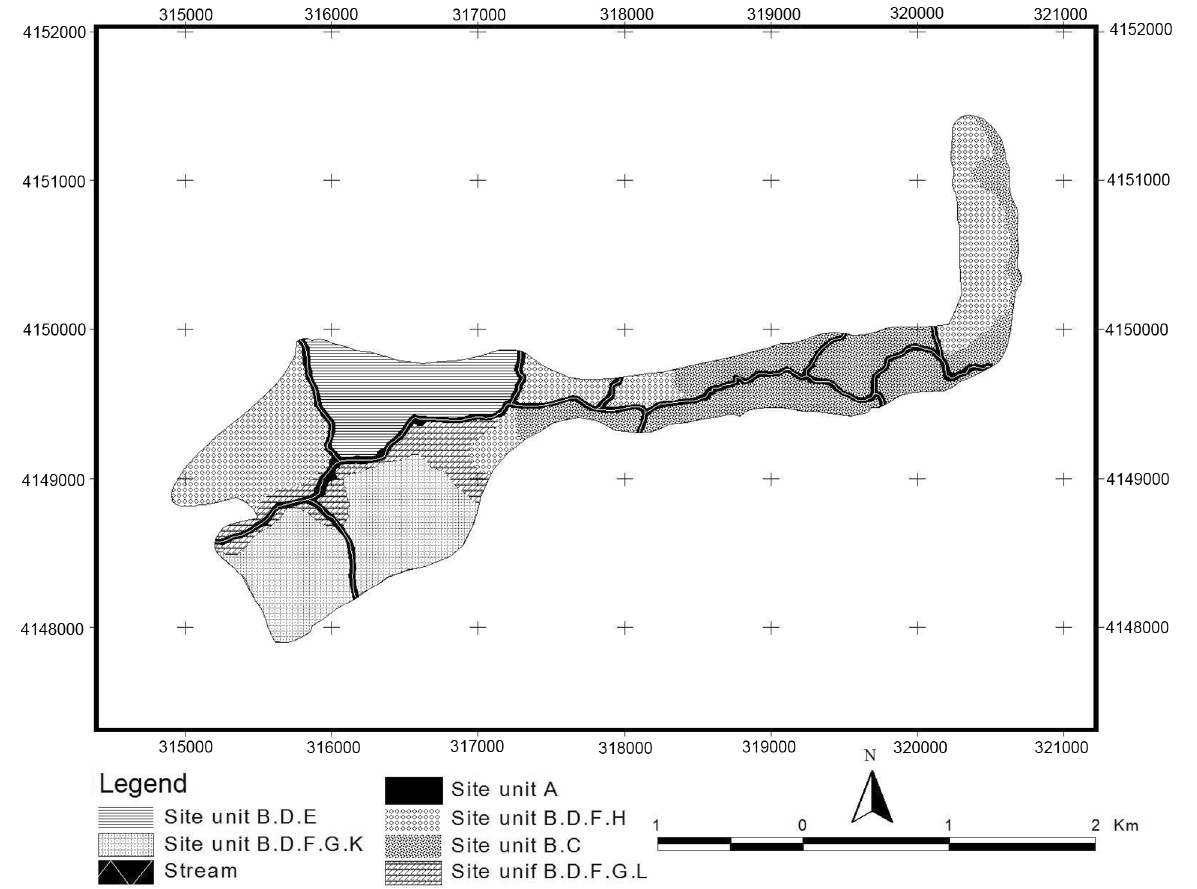
Fig. 5. Site units of the Yazili Canyon Nature